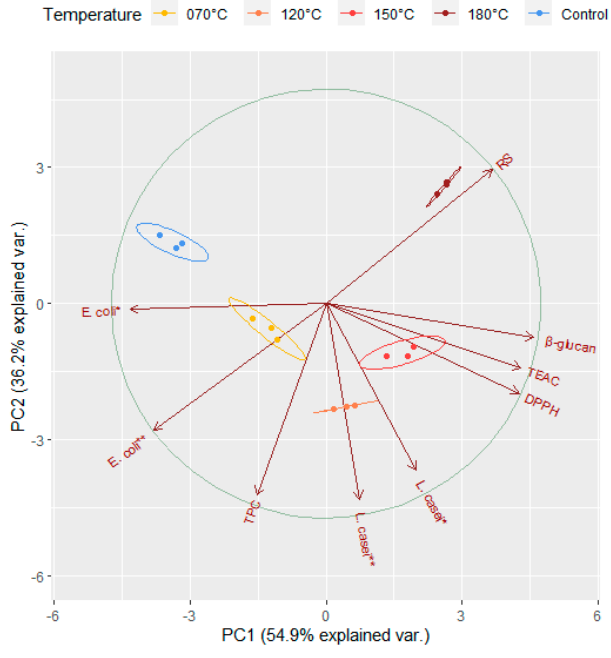
Figure 5. Principal component analysis (PCA) bi-plot for the observed variables. Vector captions: